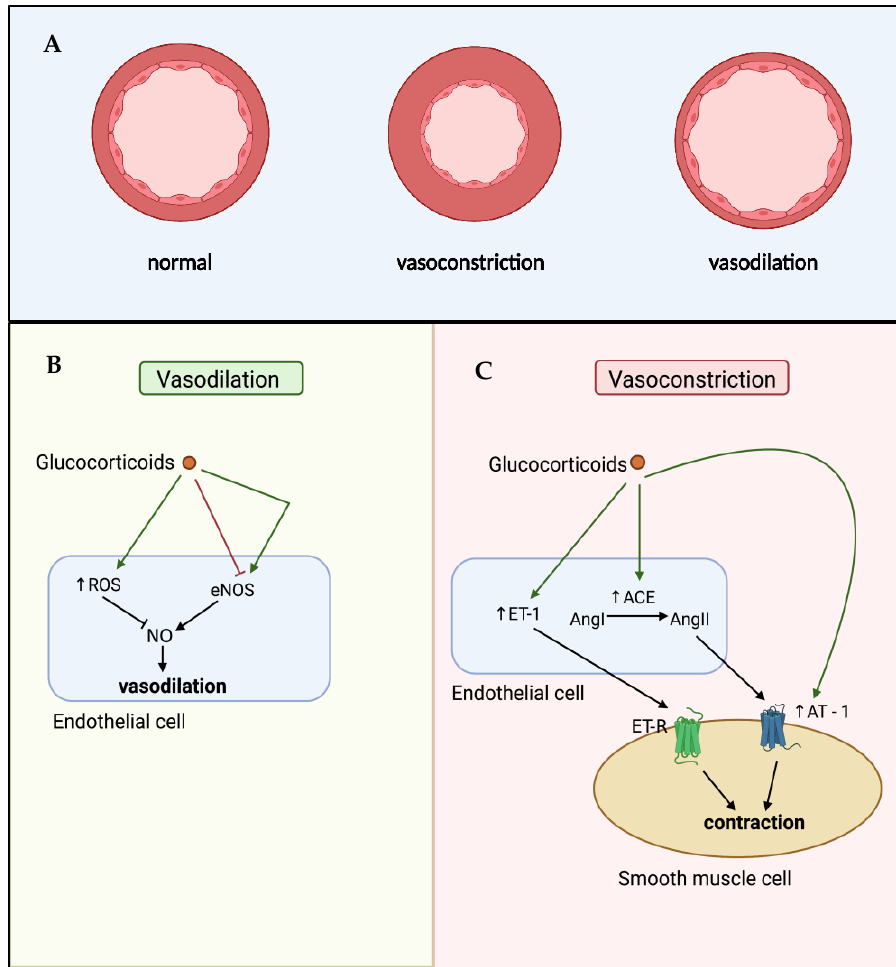
Figure 2. Glucocorticoid-mediated effects on vascular contractility. ( A ) Cross-section of an artery demonstrating comparative differences during normal conditions, under vasoconstriction, and under vasodilation. ( B ) Glucocorticoids can both inhibit and promote vasodilation in endothelial cells. Glucocorticoids can increase reactive oxygen species (ROS), which act to reduce nitric oxide (NO) availability, a key driver of vasodilation. Glucocorticoids can also inhibit NO production by reducing endothelial nitric oxide synthase (eNOS). However, there is conflicting data indicating that, under certain conditions (e.g., high dose), glucocorticoids can induce eNOS, driving NO-mediated vasodilation. ( C ) Glucocorticoids can promote vascular contractility in smooth muscle cells through increasing production and activity of the vasoconstrictors endothelin-1 (ET-1) and Angiotensin II (AngII), the latter through increased expression of angiotensin-converting enzyme (ACE) and the Angiotensin II type 1 receptor (AT-1). ET-R—Endothelin-1 receptors; AngI—angiotensin I. Glucocorticoids can also regulate vascular tone through modulation of vasodilation. In particular, they can inhibit the synthesis and release of the vasodilators nitric oxide (NO) and prostacyclin (PGI 2 ) from endothelial cells [83]. The maintenance of NO is key